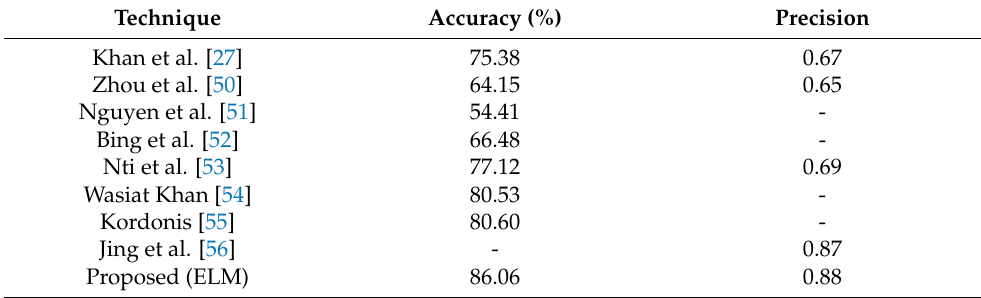
Table 10. Comparative